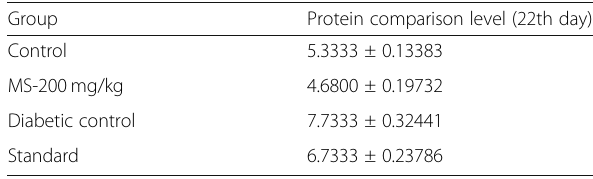
Table 5 Effects of EMSL on total protein level in alloxan Table 4 Effect of EMSL on serum uric acid level in alloxan